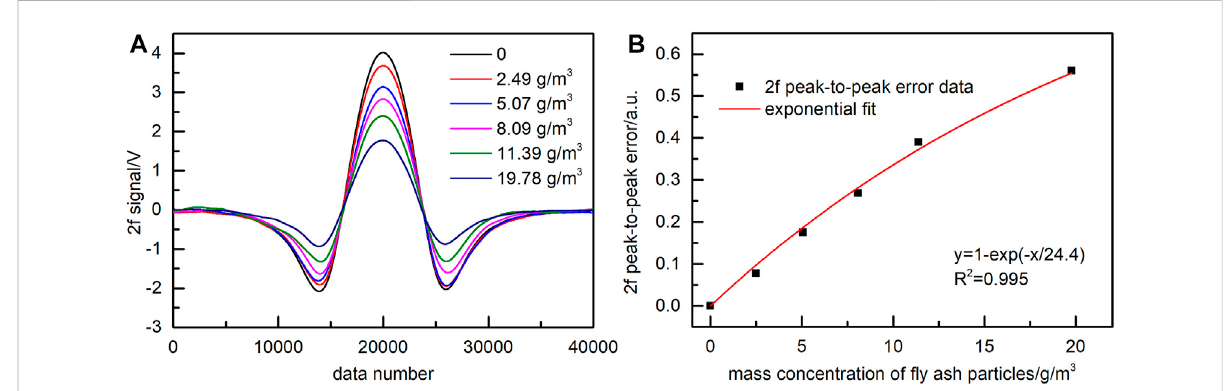
FIGURE 8 Effect of fl yash withparticlesizesintherangeof10 – 200 μ montheNO2f signal. (A) 2fsignal withremovedbackground. (B) Exponential fi tting function of 2f peak-to-peak error.